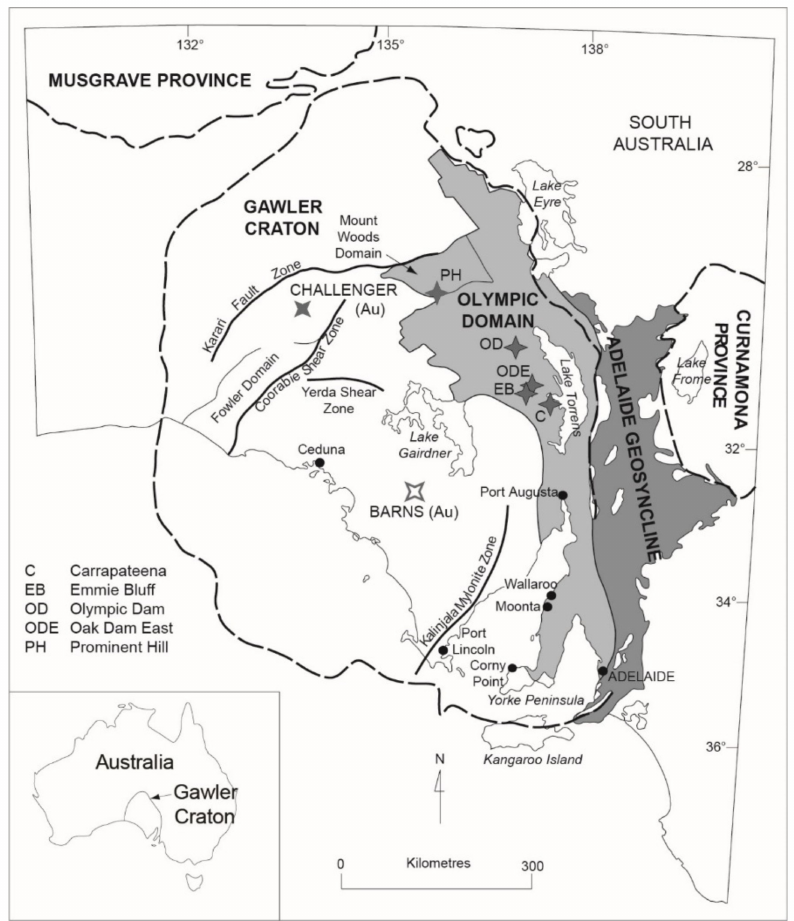
Figure 1. Geological map of the Gawler Craton showing the location of the IOCG-rich Olympic Domain as well as selected major deposits including Olympic Dam, Prominent Hill and Carrapateena. After